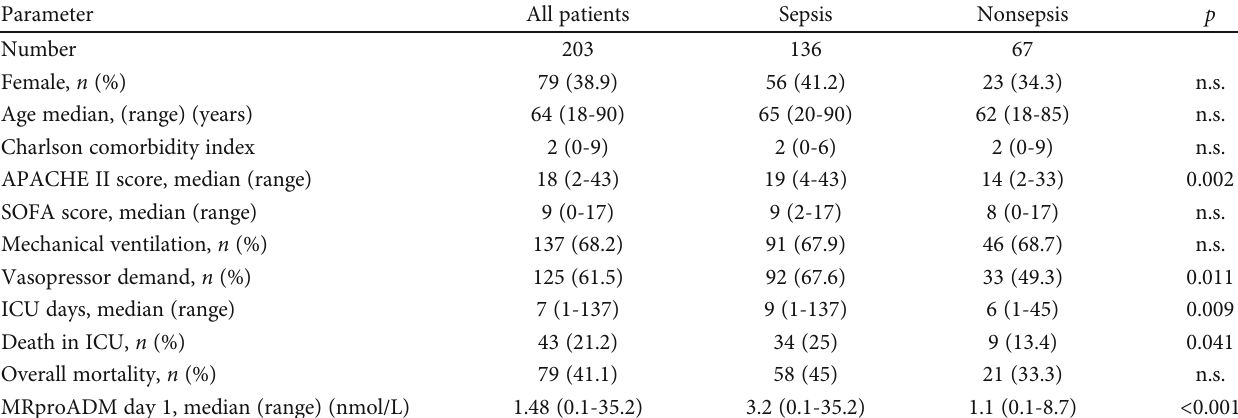
Table 2: Baseline patient characteristics and MRproADM serum